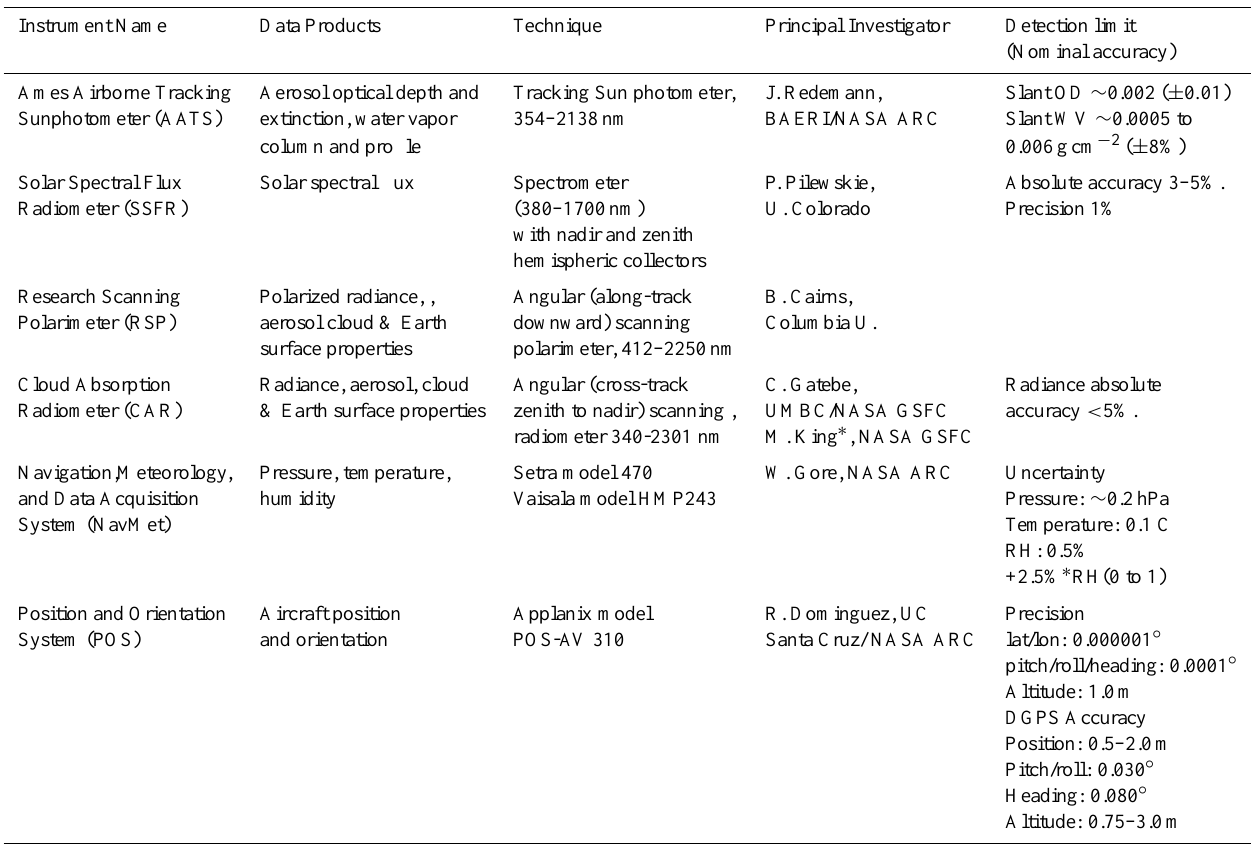
Table 7. J31 aircraft instrumentation for